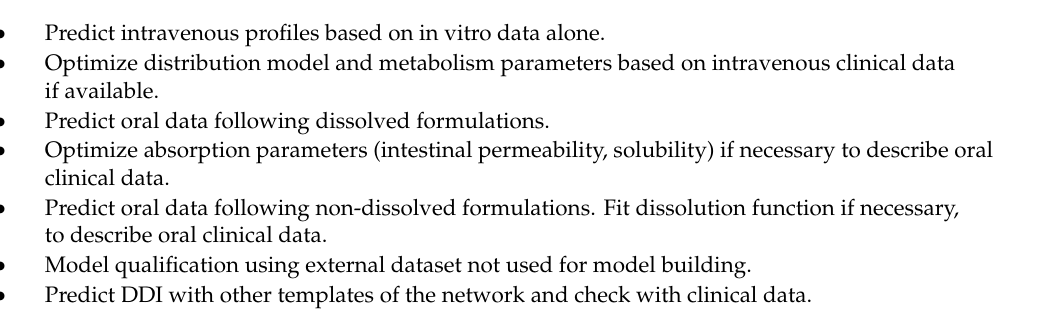
Table 2. General step-wise workflow for model